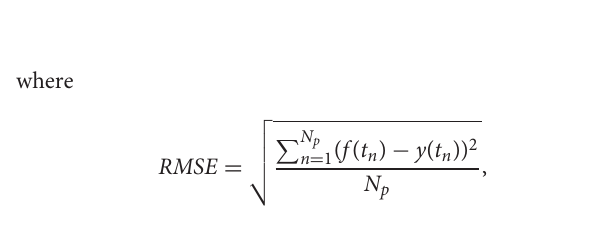
FIGURE 7 | (A) Time variation of the contagion rate in Paraíba. This function was obtained from the statistically estimated active cases described in Section 3.3 and the method of Section 3.4.2. The initial cutoff value of κ ( t ) is 0.38. (B) Corresponding reproduction number evolution. (C) Estimates for the lethality and recovery rates based on Section